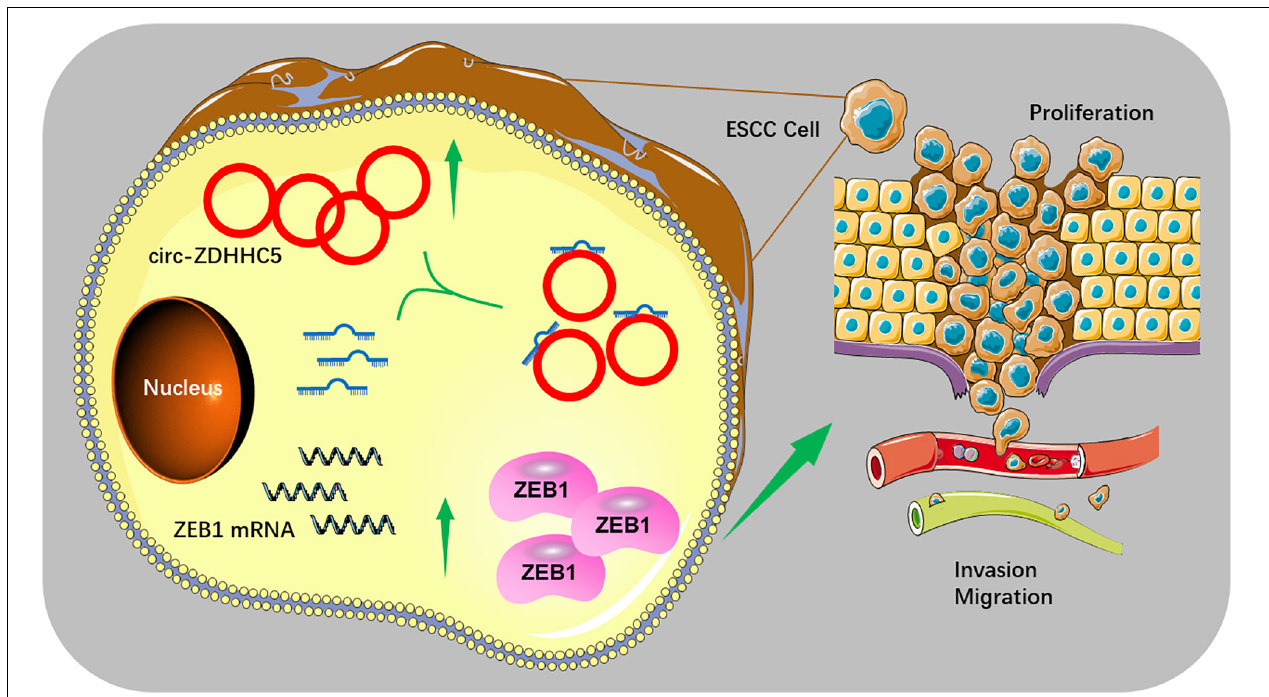
FIGURE 5 | The schematic diagram of the mechanism of the circ-ZDHHC5/miR-217/ZEB1 axis in ESCC.